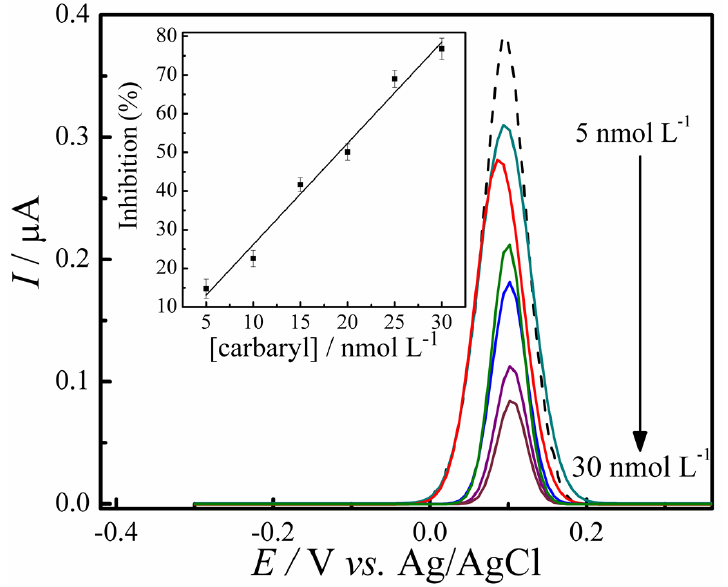
Figure 8. Baseline corrected DPV voltammograms for GC/RCF/AChE biosensor electrode in the absence (dashed line) and in the presence of 5.0–30.0 nmol L − 1 of carbaryl. Inset: linear dependence of the enzyme inhibition with carbaryl concentrations.